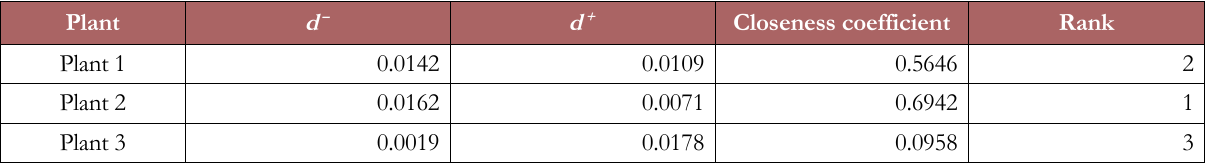
Table 6. Distance, closeness coefficient and the rank of each plant (cloud